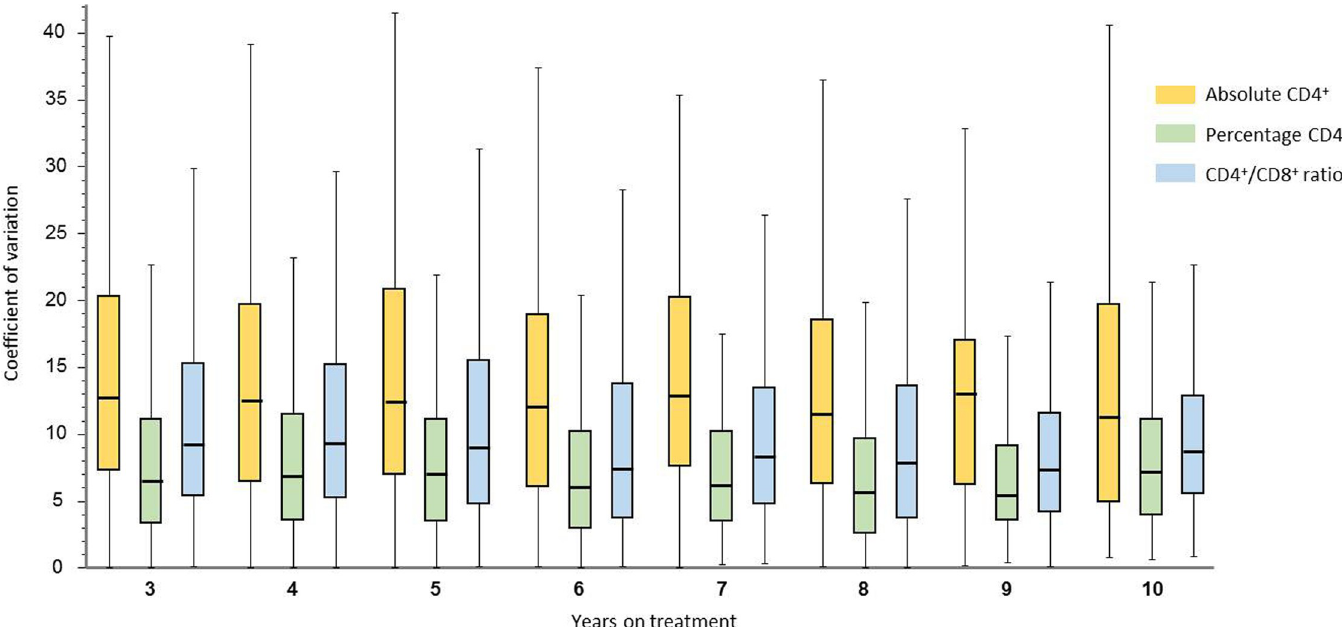
Fig 2. Intra-patient variability of absolute CD4 T cell counts, percent of CD4, and CD4/CD8 ratios from the third to the tenth year of sustained HIV viremia control. p < 0.001 for all comparisons between absolute CD4 T cell counts and CD4/CD8, except for the tenth year, p = 0.057). p < 0.001 for all comparisons between percentage of CD4 and absolute CD4 T cell counts and CD4/CD8,